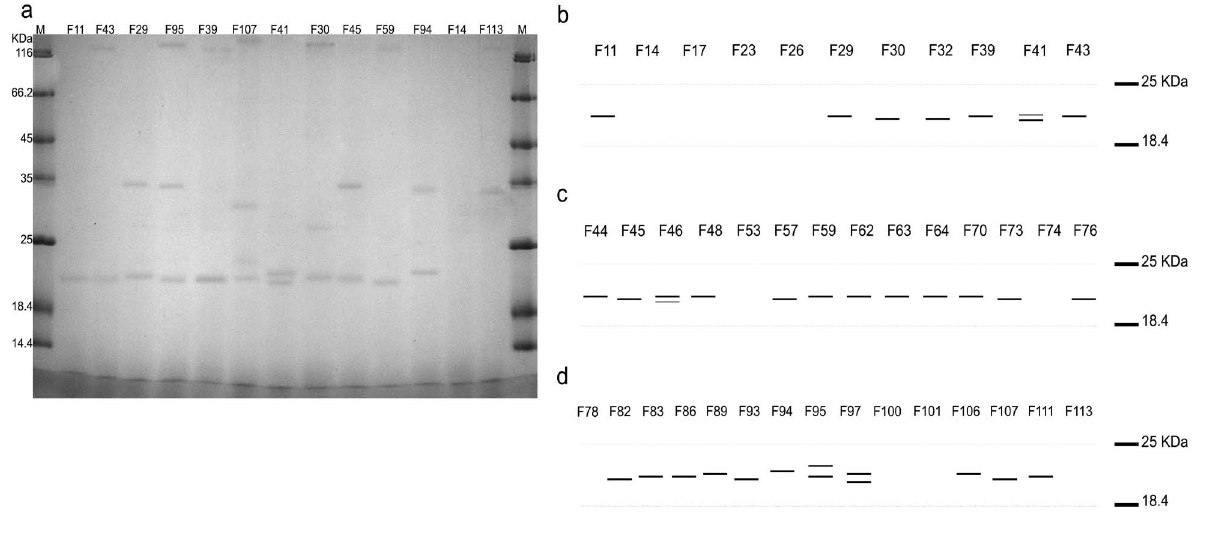
Figure 3. a, Band patterns of cutinase enzyme on SDS-PAGE. b–d, Schematic representation of SDS-PAGE band patterns of cutinase enzyme. Only cutinase bands are shown. Double peptide bands were seen in F26, F41, F46 and F97. Non-pathogenic isolates F14, F23, F53, F74, F78, F100 and F113 did not produce any cutinase